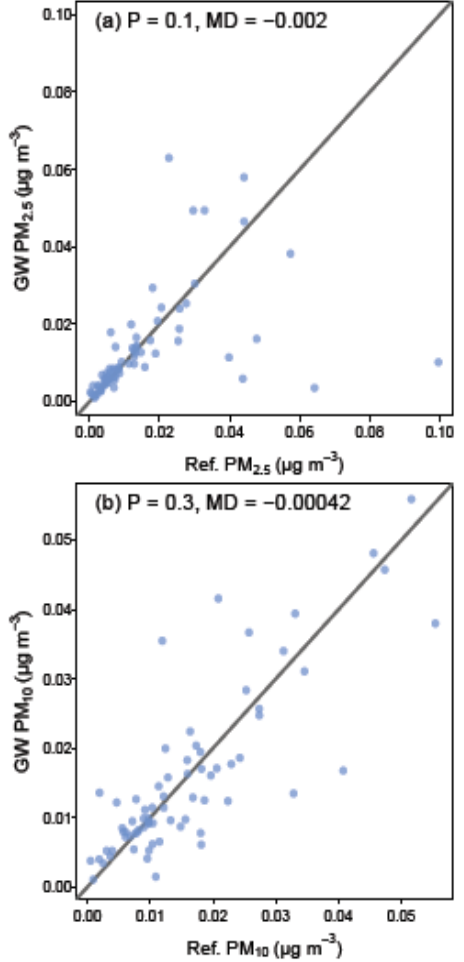
Figure 2. Scatter plots showing concentrations of PM 2.5 ( a ), and PM 10 ( b ) at the green wall ( y -axis) and matched reference wall sites ( x -axis). The black lines in ( a , b ) represent 1:1 relationships, therefore all points falling below the line indicate lower values at the green wall relative to the reference wall, and the converse for points above the line. p -values for the paired t -test and the mean difference (MD, green wall value—reference wall value) between paired samples are shown at the top of the graphs.